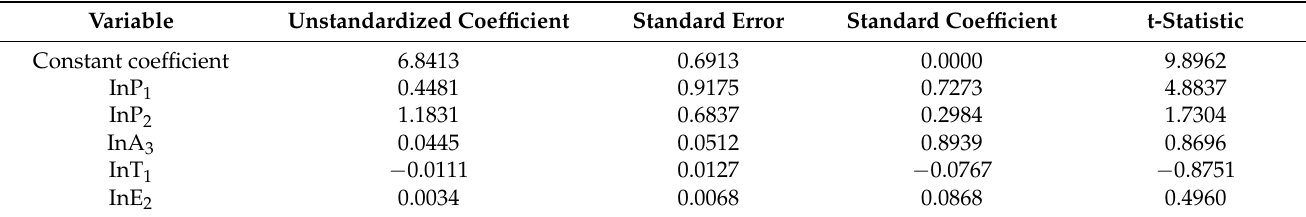
Table 7. Shanghai Model Test